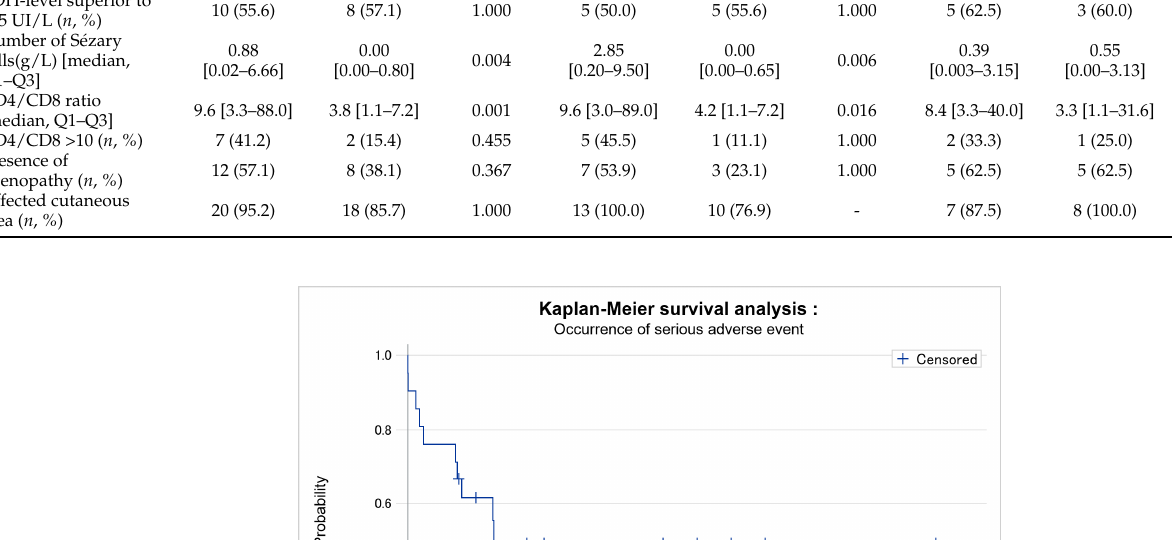
Figure 3. Kaplan–Meier survival analysis of occurrence of severe grade III–IV adverse event among the 21 patients. No missing data.